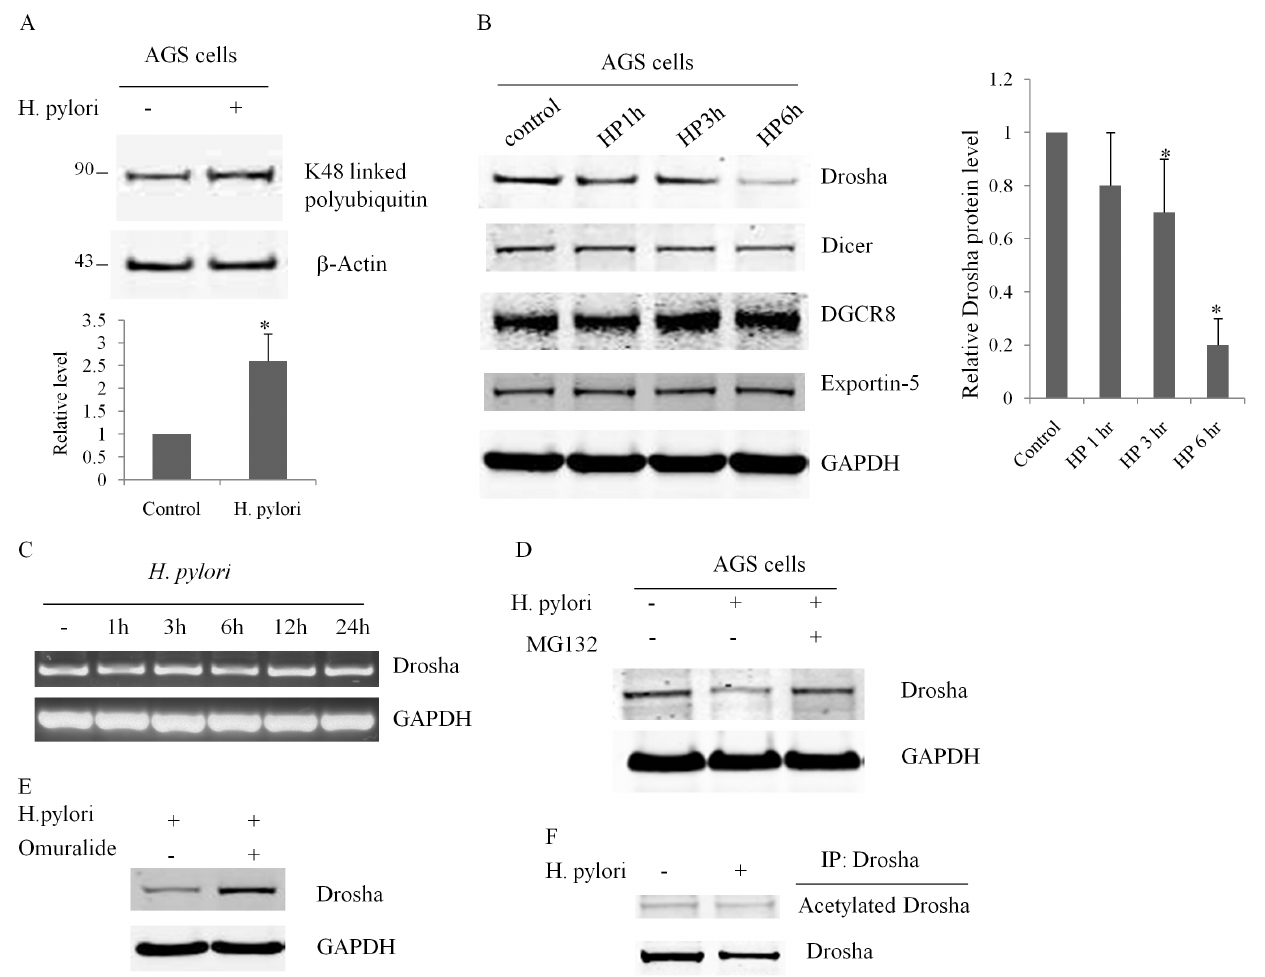
Figure 6. H.pylori infection degrades Drosha through the ubiquitin-proteasome pathway. AGS gastric epithelial cells were infected with H. pylori at a ratio of 100:1 (bacterium:cell) for different time periods. All experiments were repeated three times with similar results (p , 0.05 by Student’s t-test). ( A ) H. pylori increased levels of K48-linked polyubiquitin. AGS cells were infected with H. pylori for 6 h. Beta-Actin was used as a loading control. ( B ) Western blot revealed that Drosha protein is decreased by H. pylori infection. GAPDH was used as a loading control. Other miRNA related proteins were not affected. ( C ) H. pylori infection does not alter Drosha mRNA levels. Total mRNA from AGS cells was reverse transcribed and amplified using Drosha specific primers. Gelstar was used to stain PCR products. ( D ) MG132, a specific proteasome inhibitor, rescued Drosha from H. pylori induced degradation. AGS cells were infected with H. pylori for 6 h and GAPDH was used as a loading control. ( E ) Omuralide, another specific proteasome inhibitor, also rescued Drosha from H. pylori induced degradation. AGS cells were infected with H. pylori for 6 h and GAPDH was used as a loading control. ( F ) H. pylori infection doesn’t affect Drosha acetylation.